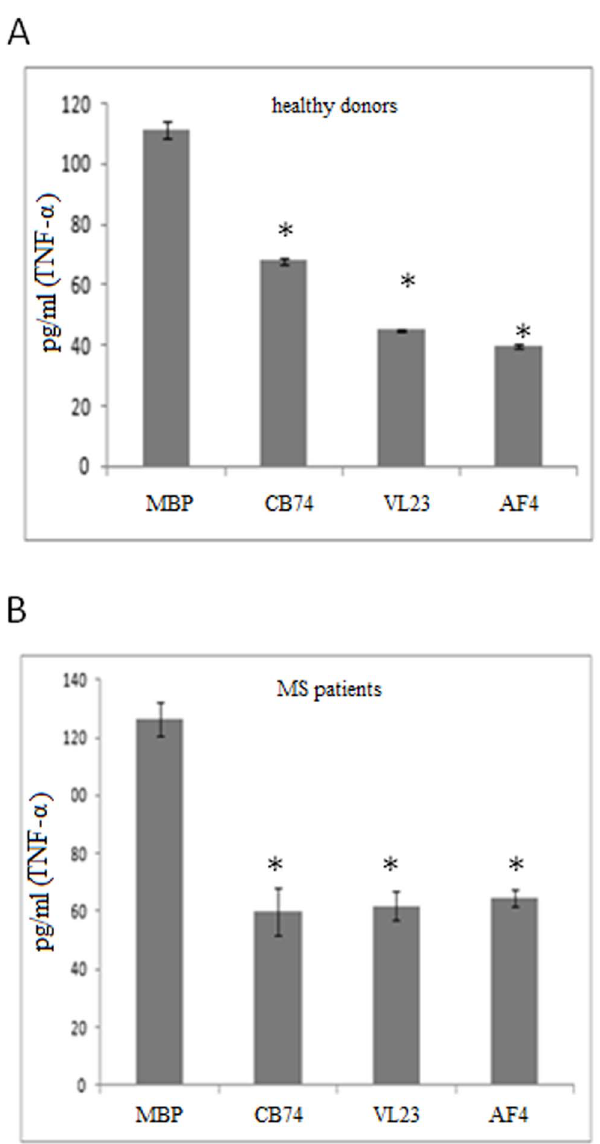
Figure 2. 1,8-naphthyridine, pyridine and quinoline derivatives inhibit TNF- a production. The histograms represent the effects of CB74, VL23 and AF4 used at10 m M,on TNF- a concentration in supernatant collected after 48 h of culture of MBP activated PBMCs isolated from healthy controls (A) and patients (B) (*p , 0,05 calculated with respect to MBP-activated PBMC, MBP in the figures). The histograms reported show a single experiment that is representative of four independent experiments with reproducible results.